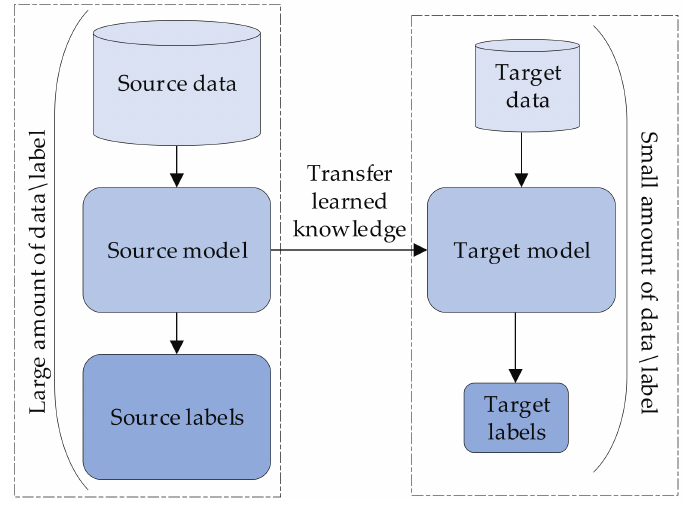
Figure 6. The concept of the transfer